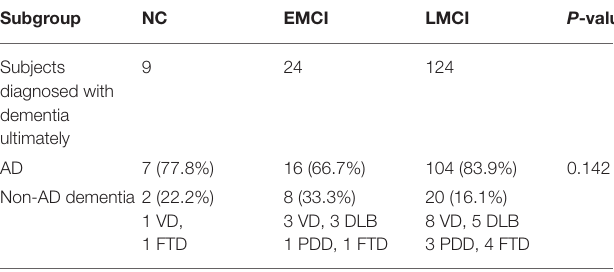
TABLE 2 | Dementia outcome and clinical